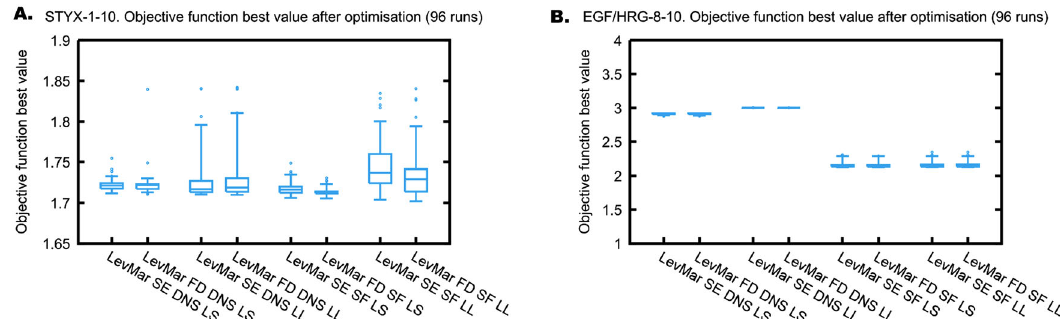
Fig. 2 Minima reached by LevMar SE and LevMar FD after the optimisation terminated. Boxplots show the median, 25th and 75th percentile, and extreme points ( dots ) outside 1.5 times the interquartile range ( whiskers ) of 96 independent runs. a STYX-1-10 optimisation problem. b EGF/HRG-8-10 optimisation problem. DNS normalisation of the simulations, LL log-likelihood, LS least squares, SF scaling factors. To facilitate the comparison, we always report the log-likelihood values on the y axis, even when LL was